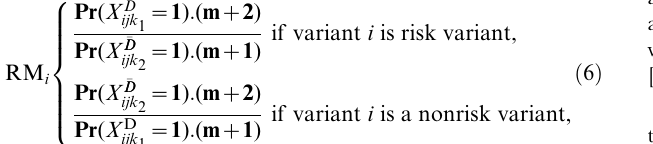
Table 5 . Association analysis of four significant variants in IFIH1 gene from T1DM patients and controls.